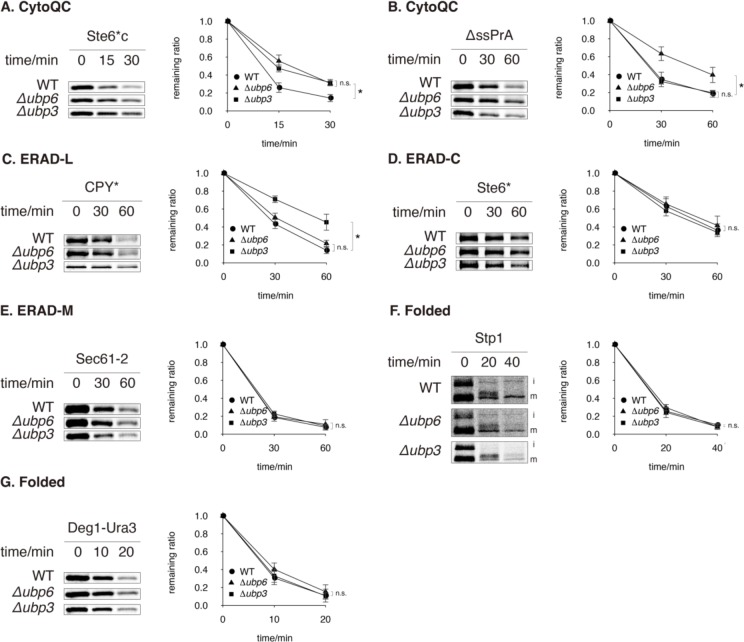
Δubp6 and Δubp3 compromise different QC pathways.(A and B) Degradation of cytosolic misfolded proteins Ste6*c and ΔssPrA. (C–E) Degradation of CPY*, Ste6* and Sec61-2, proteins that misfold in the lumen, on the cytosolic surface and in the membrane of ER, respectively. (F and G) Degradation of folded proteins Stp1 and Deg1-Ura3. The uncleaved (immature) and cleaved (mature) forms of Stp1 are respectively indicated as “i” and “m. All substrates were pulsed-labeled and then sampled at the indicated time-points. Their remaining ratios were plotted against time. t-tests were performed for each time-point between different curves. If p-value < 0.05 in at least one t-test, an asterisk (*) is indicated, or otherwise “n.s.” (non-significant) is shown.